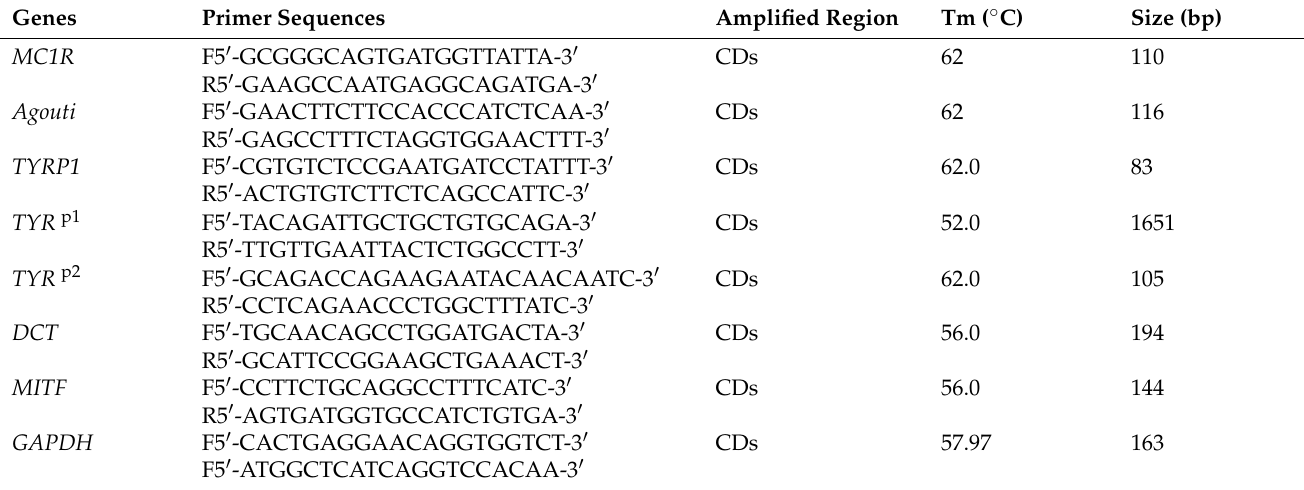
Table 1. Primer pairs designed for PCR analysis of candidate